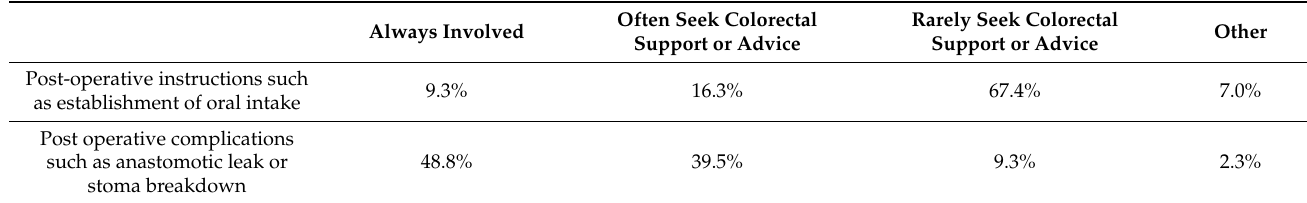
Table 3. What is the role of colorectal/general surgical teams in the post-operative period? Always